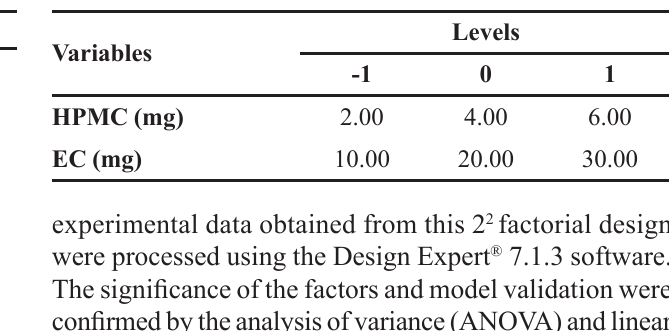
TABLE I - Composition of formulations for choosing bonding agent